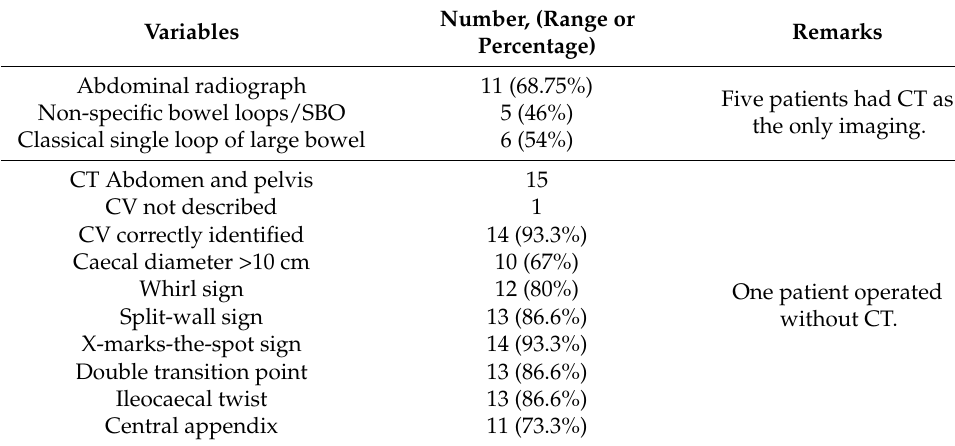
Table 3. Radiological